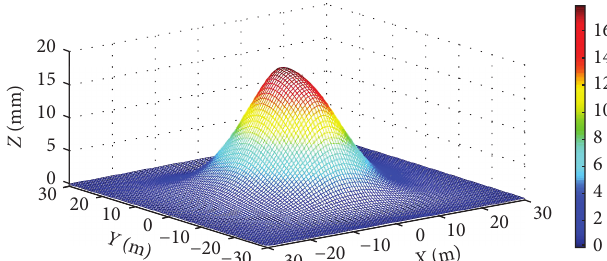
Figure 16: Heaving displacement of ground frost heave caused by freezing for 45 days (mm, α � 10 ° ).